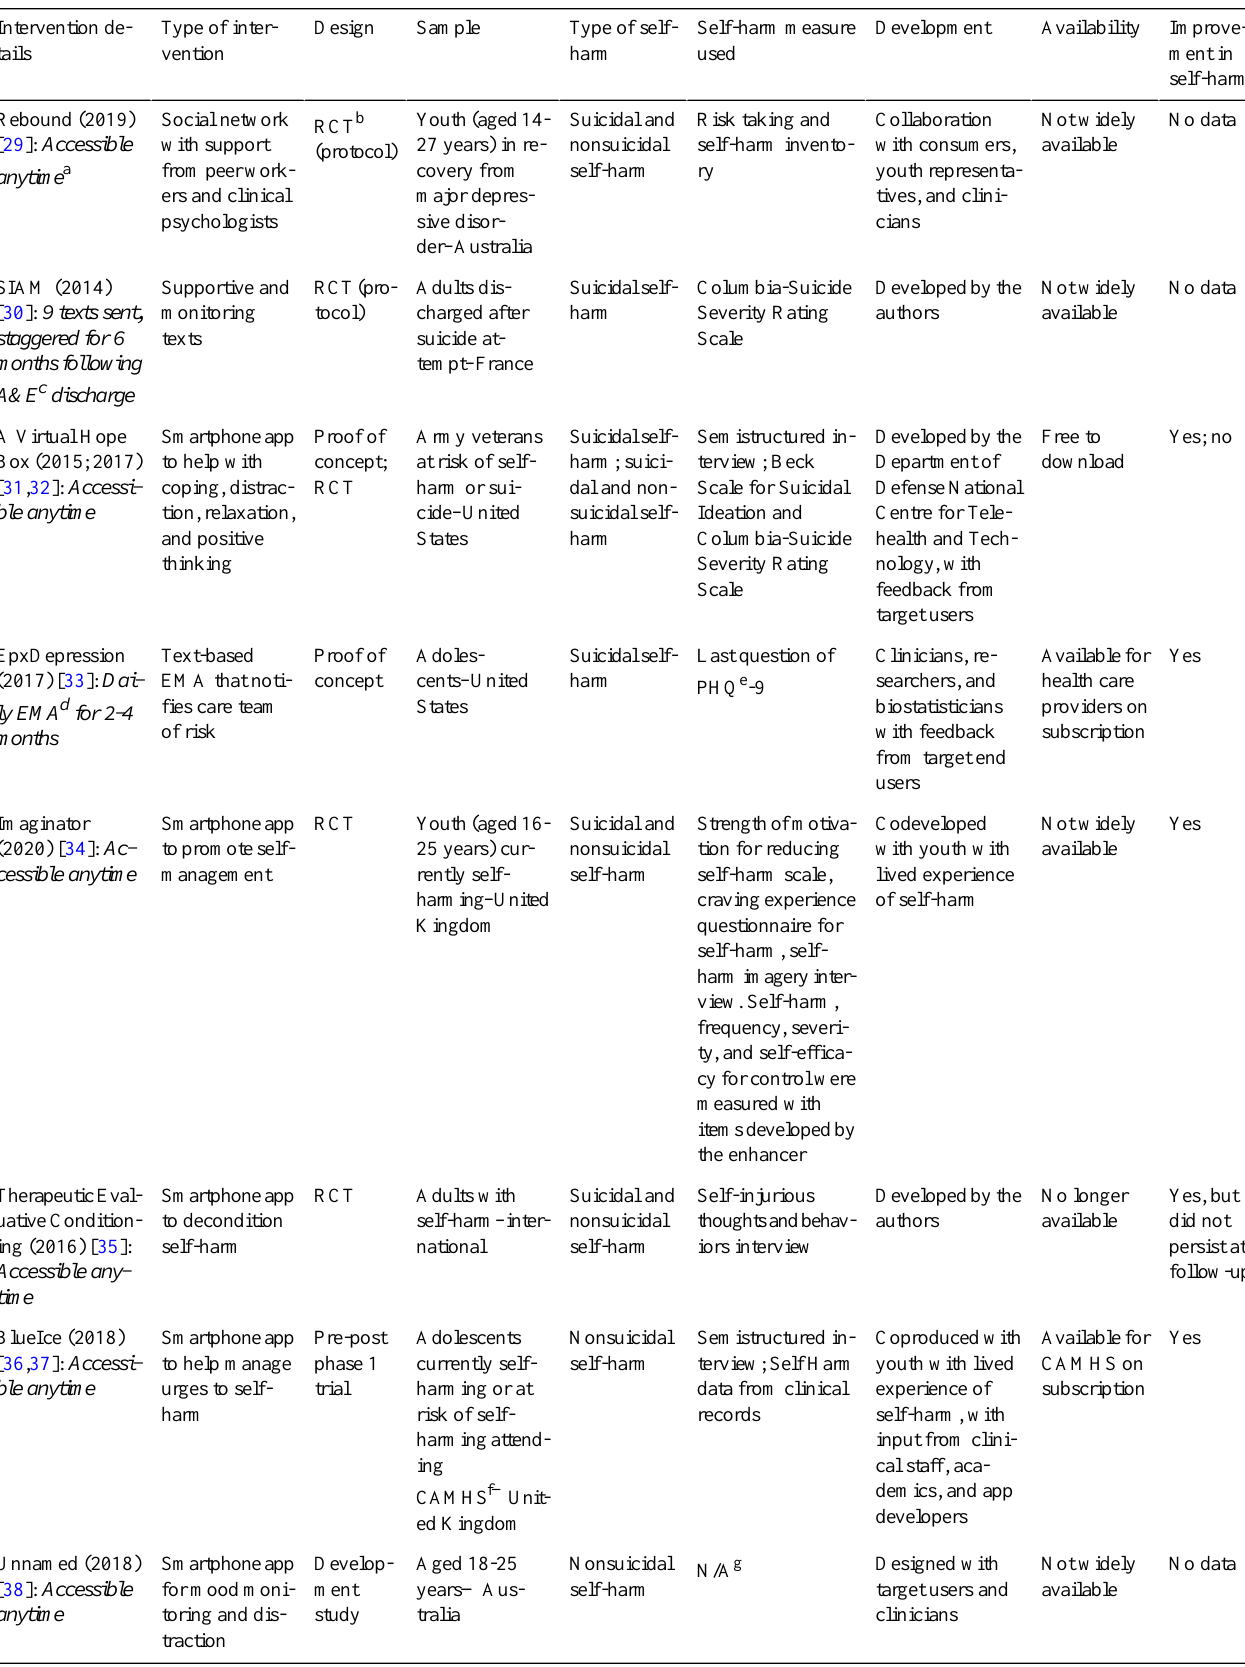
Table 1. Summary of papers (N=36).